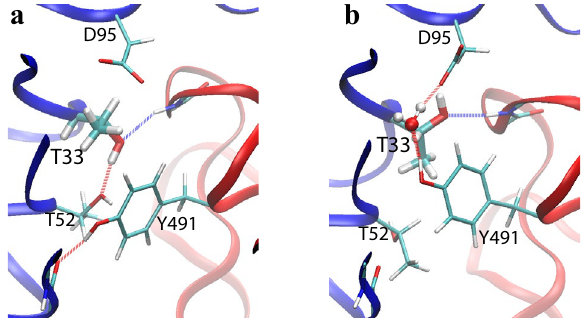
Figure 5. Snapshots of two alternative side chain conformations for the residues around Thr33 in the binding interface between the m396 heavy chain (blue) and the SARS-CoV-1 RBD (red). H-bonds between the residues are shown. In panel ( b ), a water molecule is also involved in the H-bond network. A proper equilibration between these alternative conformations would require long simulation times, thus resulting in slow convergence of the FEP calculations. Images were rendered by VMD 43 (version